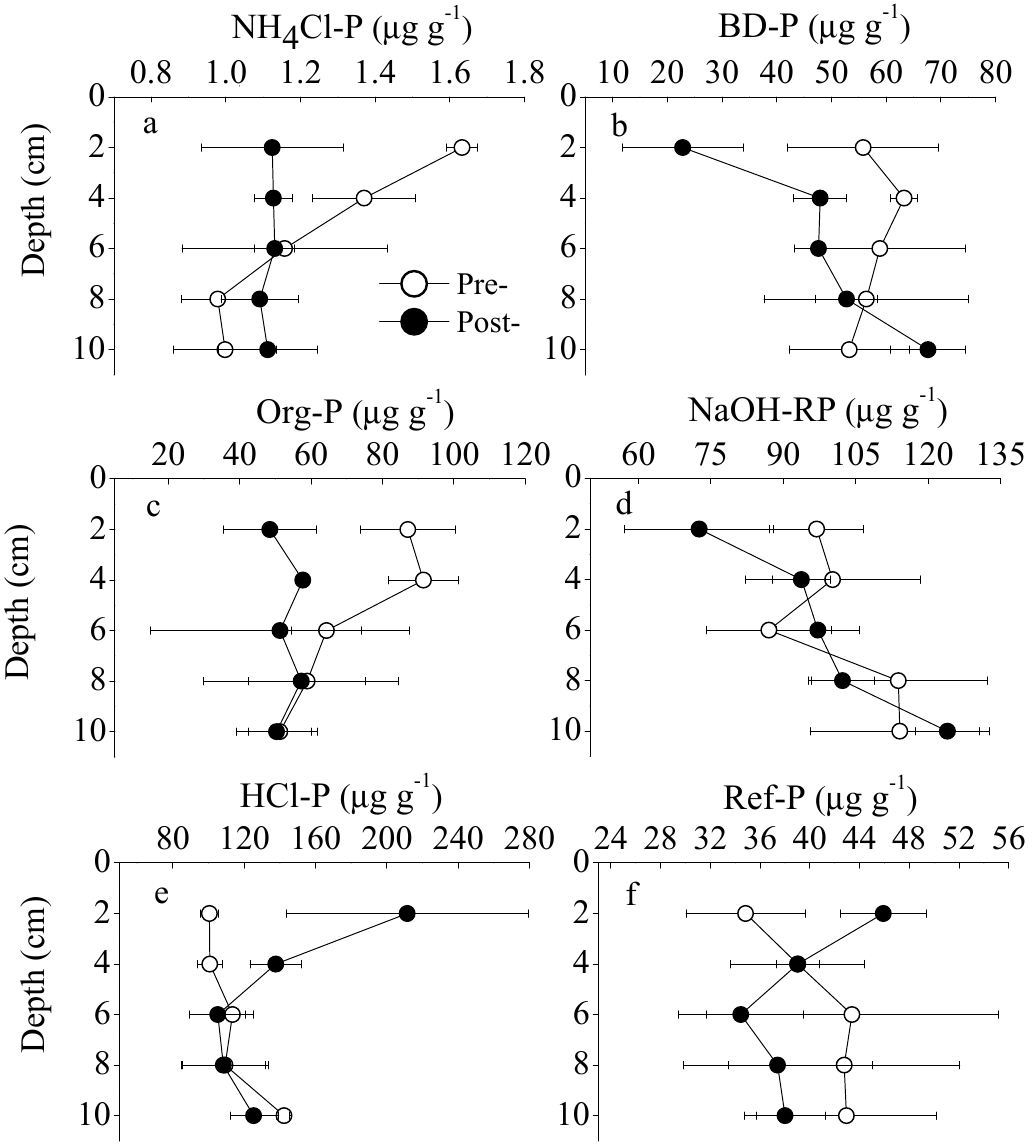
Figure 3. The concentrations of labile-P (NH 4 Cl-P) ( a ), reductant-soluble-P (BD-P) ( b ), organic-P (Org-P) ( c ), metal-oxide-P (NaOH-RP) ( d ), apatite-P (HCl-P) ( e ) and residual-P (ref-P) ( f ) in different depths of the sediments in the treatment area of Lake Yanglan in pre- (open circle) and post- (closed circle) application of PAC and Phoslock ® ( n = 3).